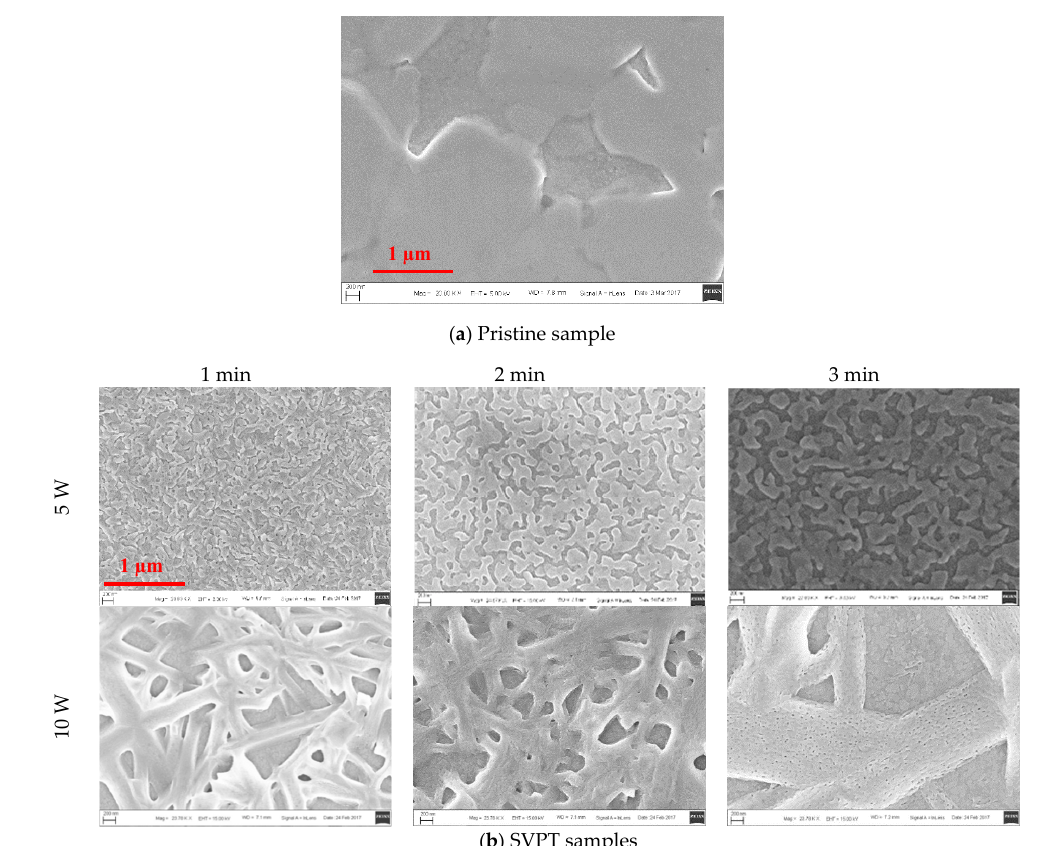
Figure 2. Top-view SEM images showing the evolution of the crystal morphology by the ultrasonic vibration time and power. ( a ) Pristine sample and ( b ) samples subjected to the SVPT at varying times and powers. All images have the same magnification and scale bar.